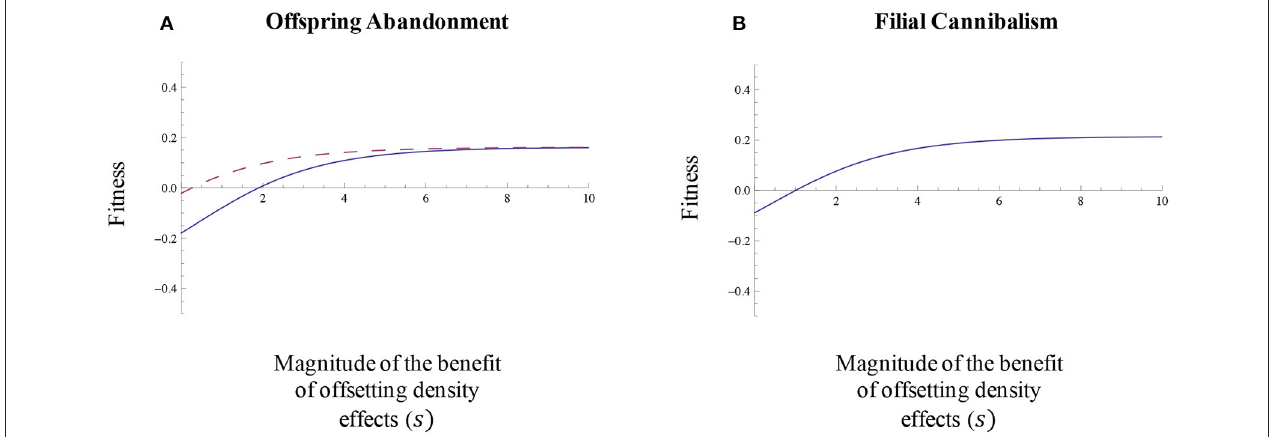
FIGURE 6 | Magnitude of the benefit of abandonment or cannibalism in relation to offsetting density effects. The fitness associated with (A) offspring abandonment that initially decreases (abandonment scenario 1, solid line) or increases (abandonment scenario 2, dashed line) egg survival and (B) filial cannibalism that initially decreases egg survival will be greater when the magnitude of the benefit of abandonment or cannibalism in relation to offsetting density effects ( s ) is relatively large (see also Equations 21 and 22 in the main text for additional details). In these scenarios, β = 0.6 and all other parameter values are as described in the text.